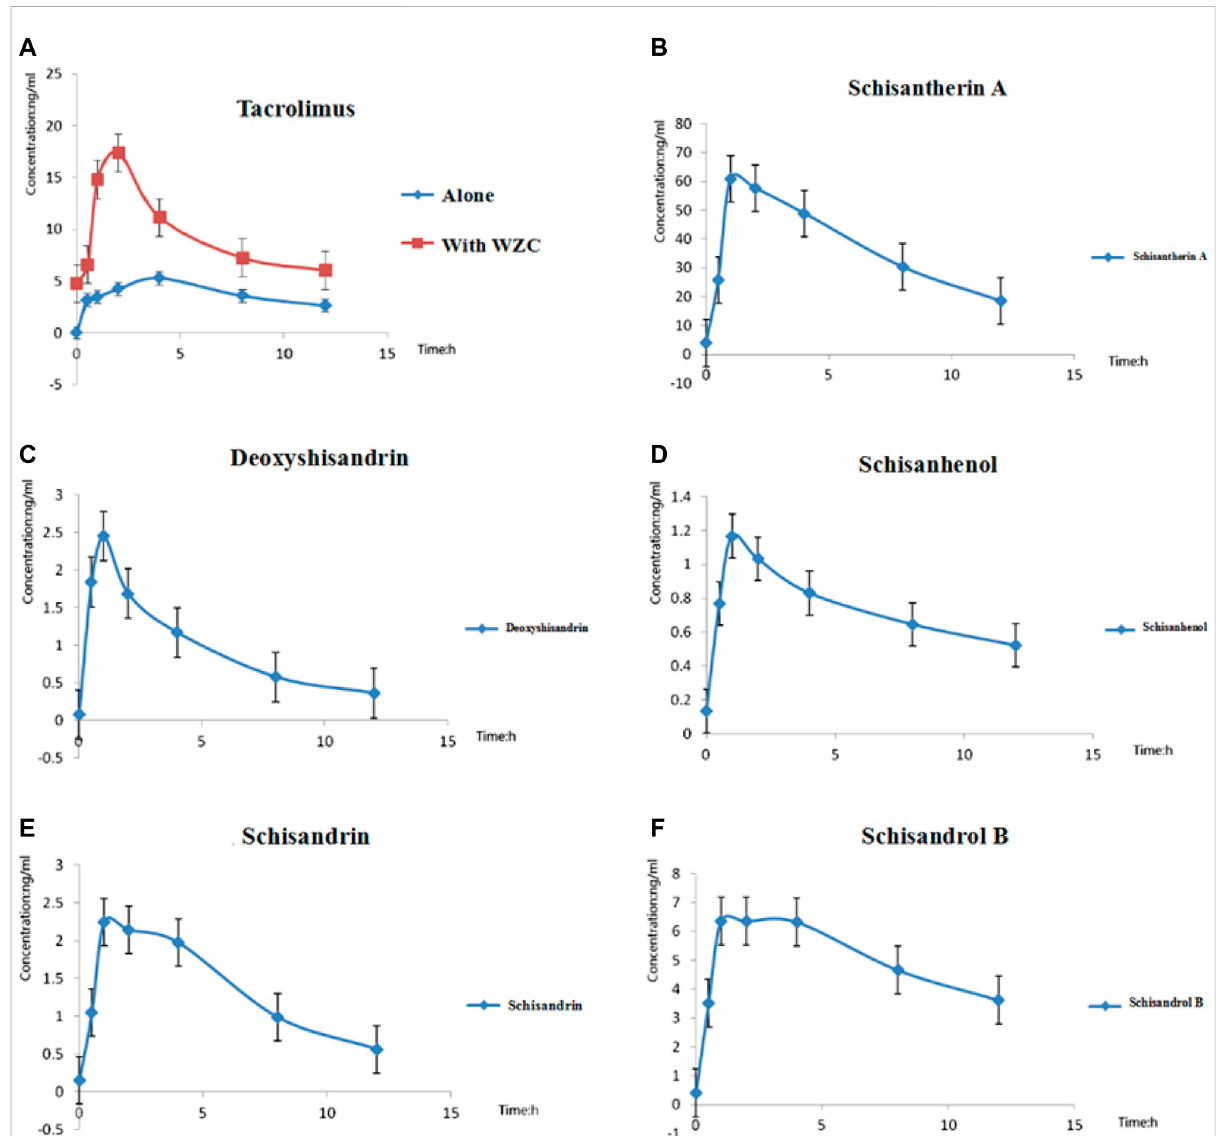
FIGURE 1 The blood concentration vs. time curves of all the analytes. (A) Mean blood concentration – time curves of tacrolimus with or without WZC ( n = 15); (B) Mean blood concentration – time curves of schisantherin A after oral administration of tacrolimus with WZC ( n = 15); (C) Mean blood concentration – timecurvesofdeoxyshisandrinafteroraladministration oftacrolimuswithWZC( n =15); (D) Meanbloodconcentration – timecurves of schisanhenol after oral administration of tacrolimus with WZC ( n = 15); (E) Mean blood concentration – time curves of schisandrin after